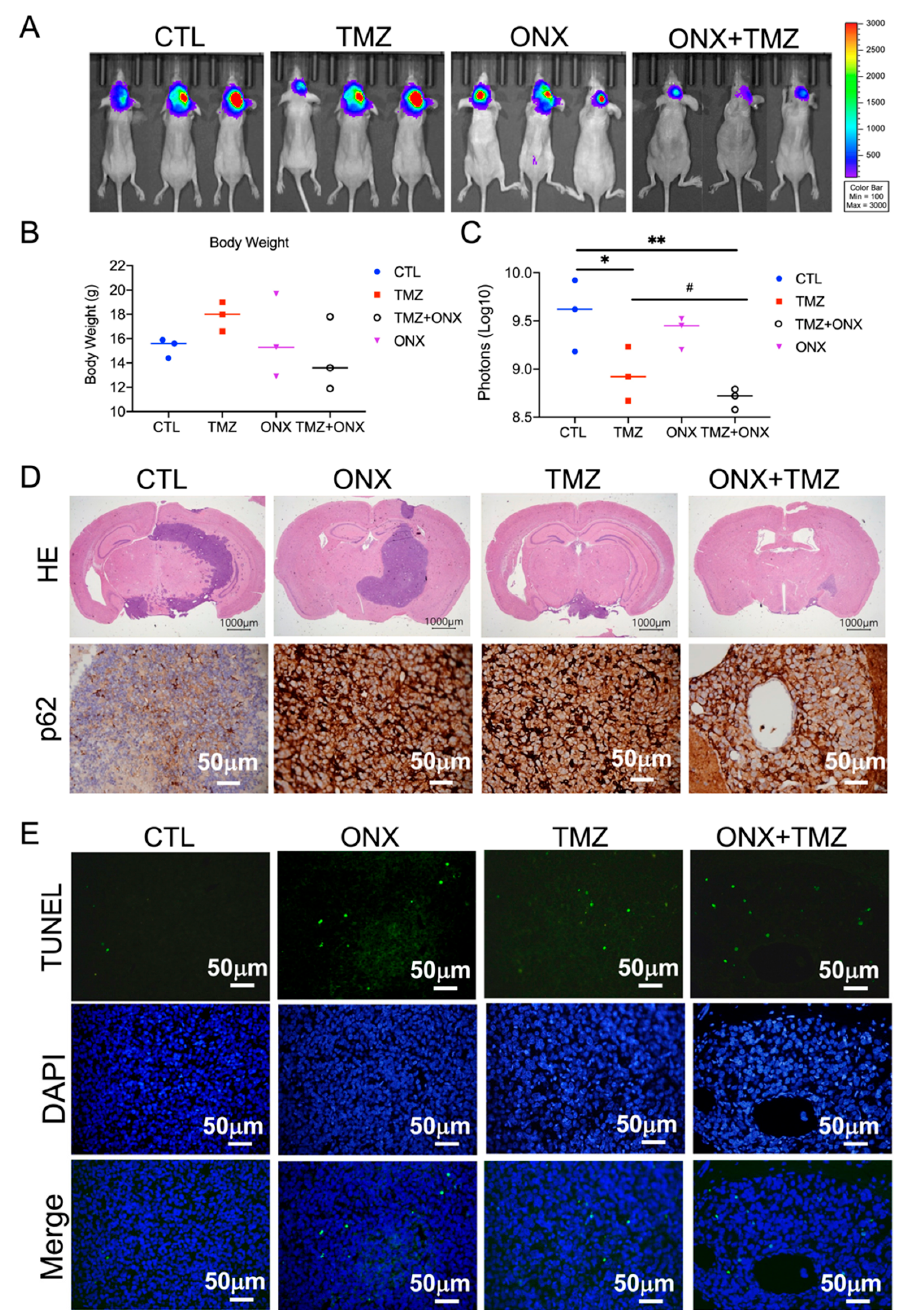
Figure 7. The effect of ONX-0914 on tumor progression in an orthotropic human glioblastoma xenograft model. LN229 human glioblastoma cells were implanted into nude mice. Placebo (CTL), temozolomide (TMZ), ONX-0914, and TMZ plus ONX-0914 were then administered every day for 15 days. ( A ) The in vivo bioluminescent imaging analysis of the different treatments were acquired by the In Vivo Imaging System (IVIS). ( B ) The body weight was measured and compared to the placebo group. ( C ) The luminescent intensity of photons emitted from each animal was quantified. ( D ) Representative image showing H&E and p62 staining of the xenograft orthotropic brain. ( E ) Apoptosis was measured using TUNEL and counterstaining with DAPI. *, p < 0.05; **, p < 0.01 compared to the placebo group. #, p < 0.05 compared to the TMZ